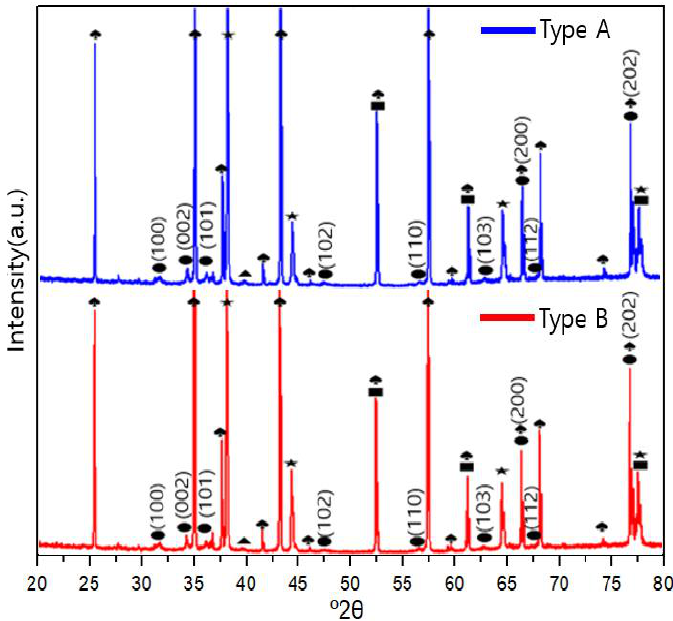
Figure 6. XRD patterns for the type A and type B samples. Patterns show Al 2 O 3 ( ♠ ), Au ( ★ ), ZnO ( ● ), C ( ■ ), and Pt ( ▲ ), and the components indicated by each peak are shown.